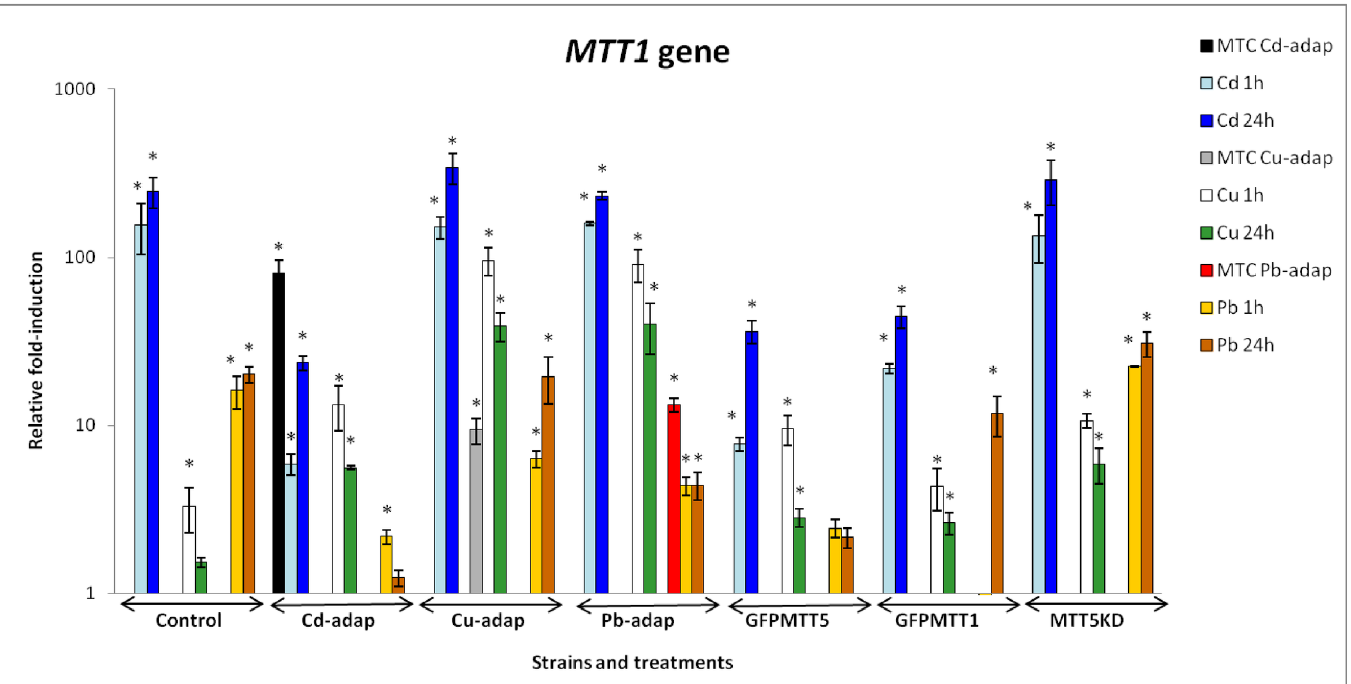
Fig 2. Comparison of relative fold-induction of MTT1 in different T . thermophila strains. MTC: maximum tolerated concentration (115 μ M Cd 2+ , 4 mM Cu 2+ or 5.5 mM Pb 2+ ). β -actinwas used as the normalizergene. Each histogrambar represents an averagevalue ± standarddeviation(see S3 Table) from two or three independentexperiments. Relativeinductionvalues are representedin a logarithmic scale. Asterisks indicatesignificantdifferencesfrom the control with p (cid:20) 0.05.